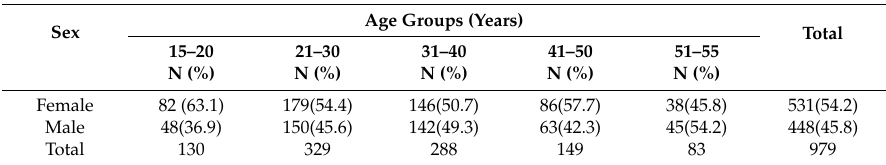
Table 1. Demographic characteristics of the study participants from four villages, Ilemela district, north-western Tanzania.